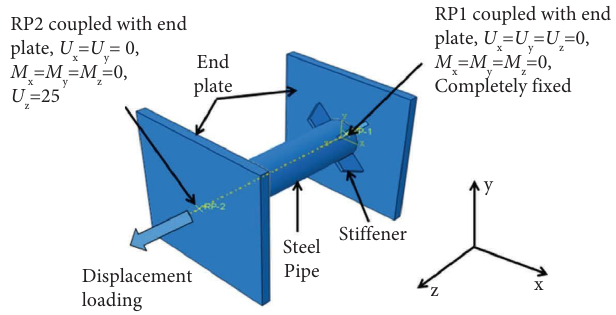
Figure 17: Boundary